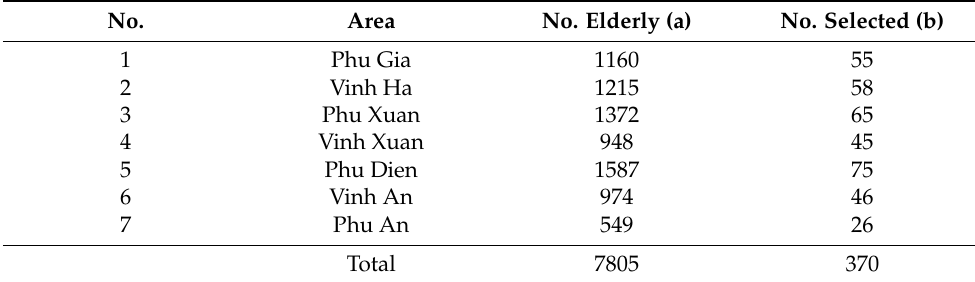
Table 1. Sampling estimate of study participants selected for each area. No. Area No. Elderly (a) No. Selected